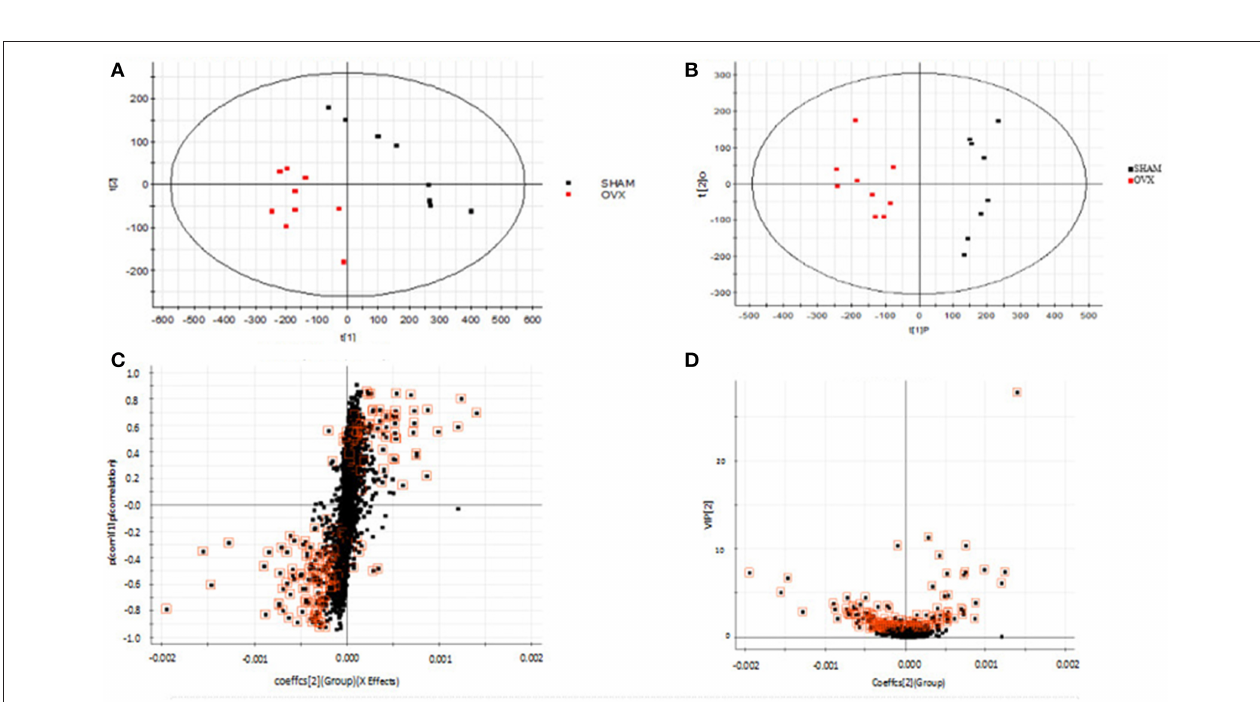
FIGURE 3 | Metabolomics profiling of ovariectomized osteoporosis in positive ion mode at 7 weeks: (A) score plot of serum profile of sham operation group and model group scanned by PCA analysis. (B) Score plot of serum profile of sham operation group and model group scanned by OPLS-DA analysis. (C) S-plot of serum profile of sham operation group and model group scanned by OPLS-DA analysis. (D) VIP-plot of serum profile of sham operation group and model group scanned by OPLS-DA